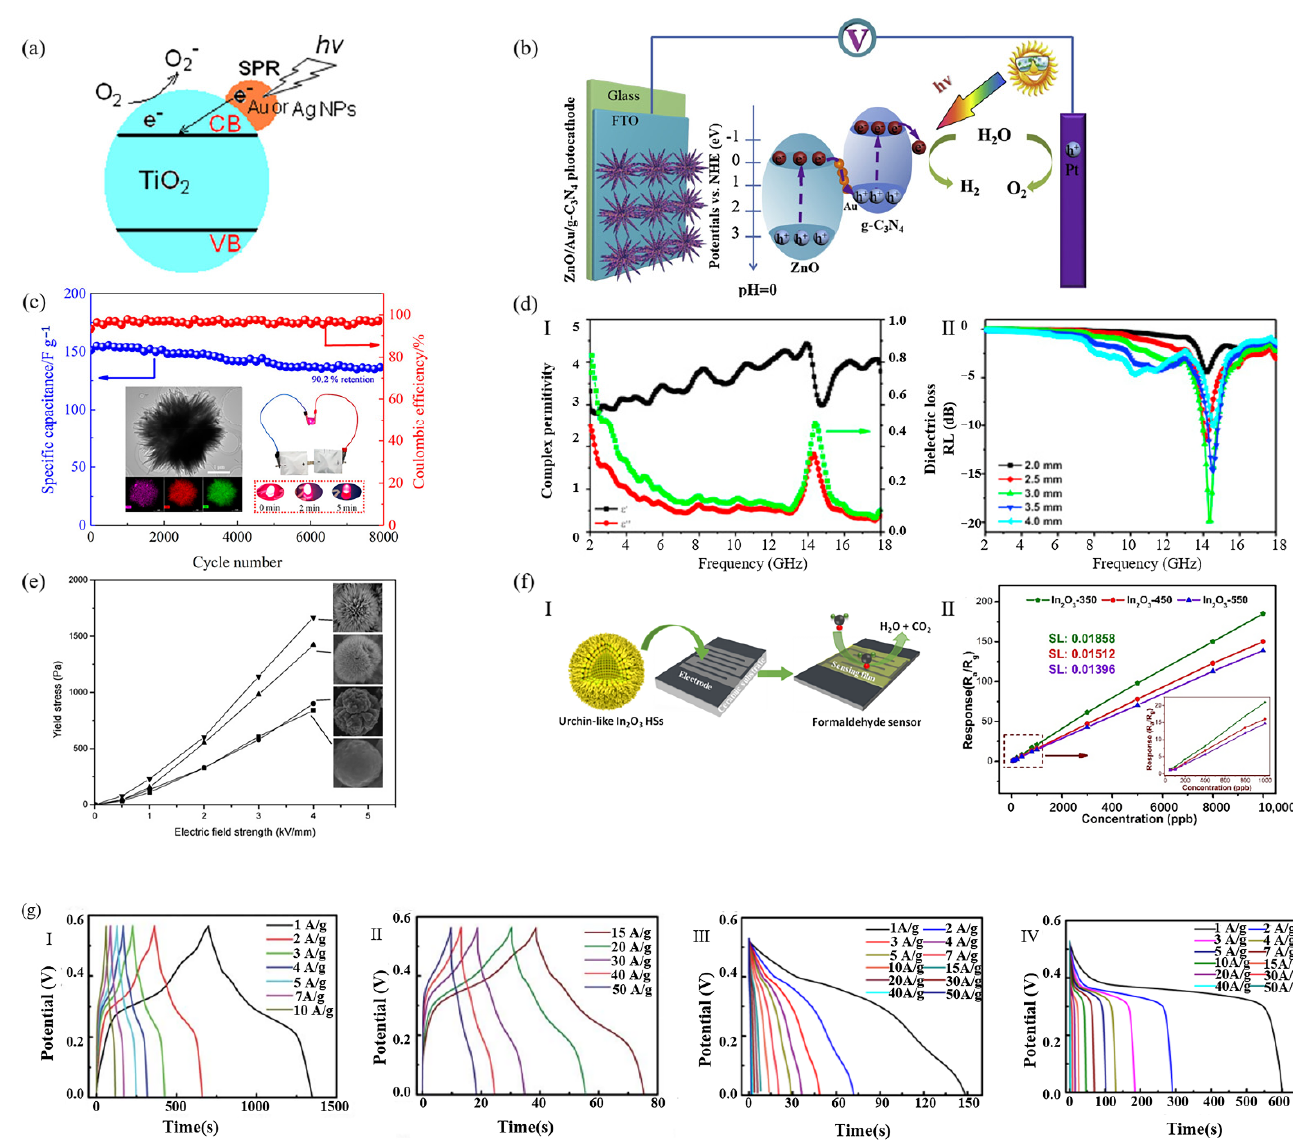
Figure 8. Overview of the application of urchin-like micro-/nanoparticles in different fields: ( a ) Schematic illustration of the surface plasmon-enhanced photocatalysis mechanism of Au or Ag-decorated TiO 2 nanostructures under light irradiation [102] (Reprinted with permission from ref [102]. Copyright 2013 Elsevier). ( b ) Schematic diagram of the PEC reaction mechanism of the 3D urchin-like ZnO/Au/g-C 3 N 4 photocathode, EIS Nyquist plots [69] (Reprinted with permission from ref [69]. Copyright 2019 Elsevier). ( c ) TEM of MnCo-selenide. TEM mapping of Co, Mn, Se. Images of the red LED lit by two ASCs in series [52] (Reprinted with permission from ref [52]. Copyright 2019 American Chemical Society). ( d ) The complex permittivity (I) and RL curves (II) of calcined ZnO/paraffin wax composite [83] (Reprinted with permission from ref [83]. Copyright 2015 Else- vier). ( e ) Yield stress as a function of electric field strengths for the suspensions of Cr-doped titania particles with different surface morphologies (T ¼ 23 °C, 10 vol%.) [103] (Reprinted with permission from ref [103]. Copyright 2009 The Royal Society of Chemistry). ( f ) (I) Schematic illustration for sensor fabrication. (II) The linear relationship between the response and HCHO concentration (inset: 50–1000 ppb) [104] (Reprinted with permission from ref [104]. Copyright 2019 Elsevier). ( g ) Electro- chemical performances of the ternary NiCo 2 S 4 urchin-like nano-structure: (I,II) galvanostatic charge–discharge curves measured with different current densities of 1–50 A g − 1 ; (III) Co 9 S 8 ; (IV) NiS [43] (Reprinted with permission from ref [43]. Copyright 2013 The Royal Society of Chemistry).